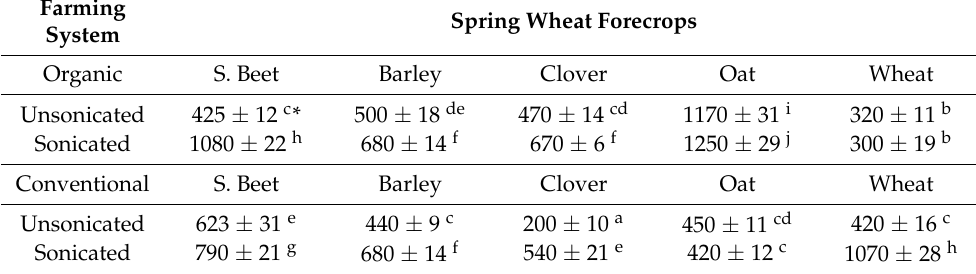
Table 8. Ultrasound viscosity (mPas g/cm 3 ) of gluten